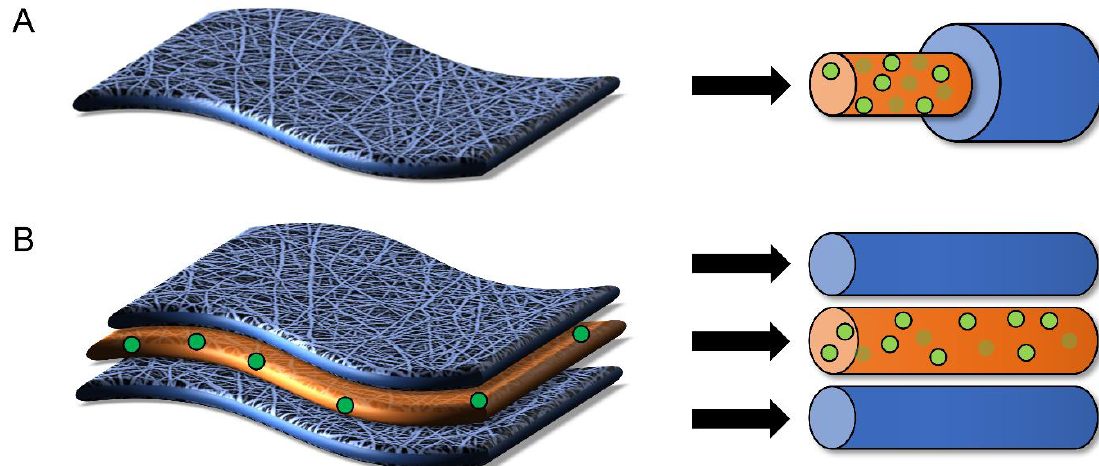
Figure 6. Schematic of electrospun nanoparticle-fiber composites that integrate coaxial and multilayered fiber architectures. ( A ) Coaxial fibers can be fabricated to encapsulate nanoparticles (NPs) within the core fiber, conferring sustained- or delayed-release of active agents that are encapsulated in NPs (shown in green). ( B ) Multilayered fibers that encapsulate NPs can also act as reservoirs for either NP or active agent